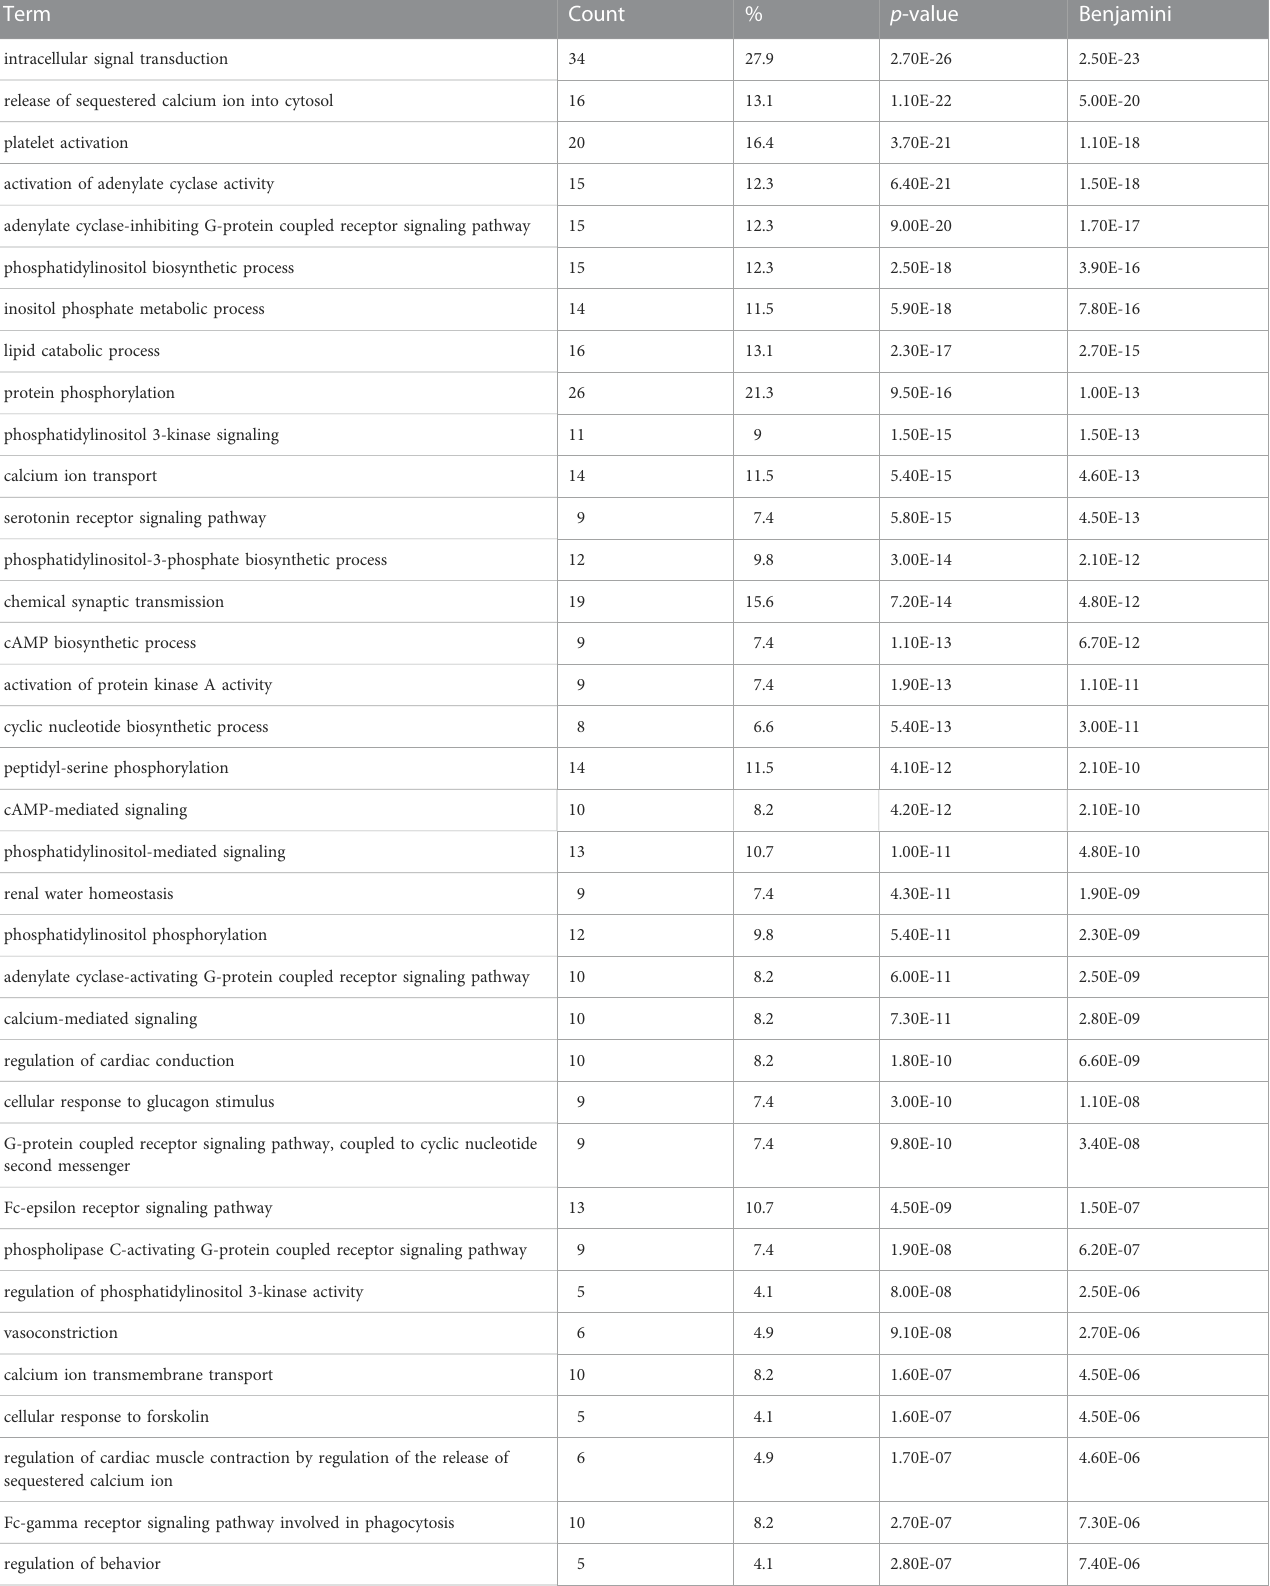
TABLE 2 Gene Ontology Enrichment – Biological Process (Most signi fi cant results). Gene ontology biological process enrichment analysis performed on the set of 125 shrew (Cryptotis parva) candidate genes for emesis. Term corresponds to the gene ontology term, count indicates how many genes within the 125 candidate gene set contained the biological process annotation, % is the percent of genes containing the annotation within the emesis candidate gene set, p -value is the uncorrected p - value, Benjamini corresponds to the false discovery rate associated with type I errors in null hypothesis in cases of multiple testing. Complete set of gene ontology biological process enrichment data in Supplementary Table